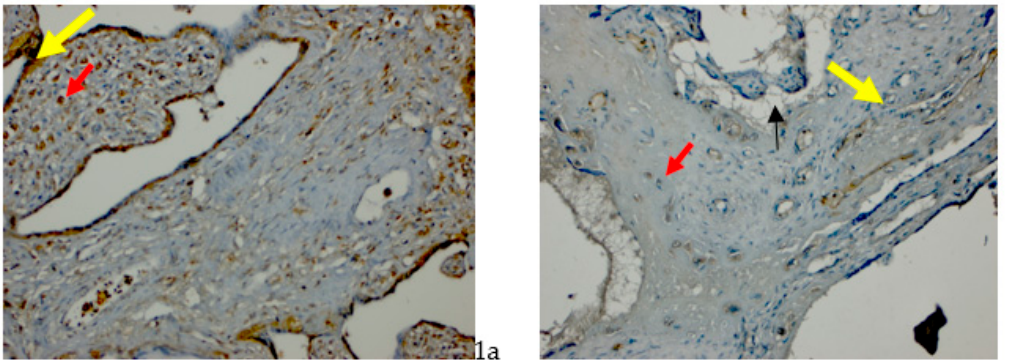
Figure 1. ( a ) Preeclampsia group, an increased positive expression in decidual cells (red arrow), syncytitial nodes (yellow arrow) and endothelial cells; Bax immunohistochemistry stain, Bar 100 µm. ( b ) Preeclampsia group, a weak Bcl-2 expression in decidual cells (red arrow), syncytial nodes (arrow) and cytotrophoblast cells (yellow arrow); Bcl-2 immunohistochemistry stain, Bar 100